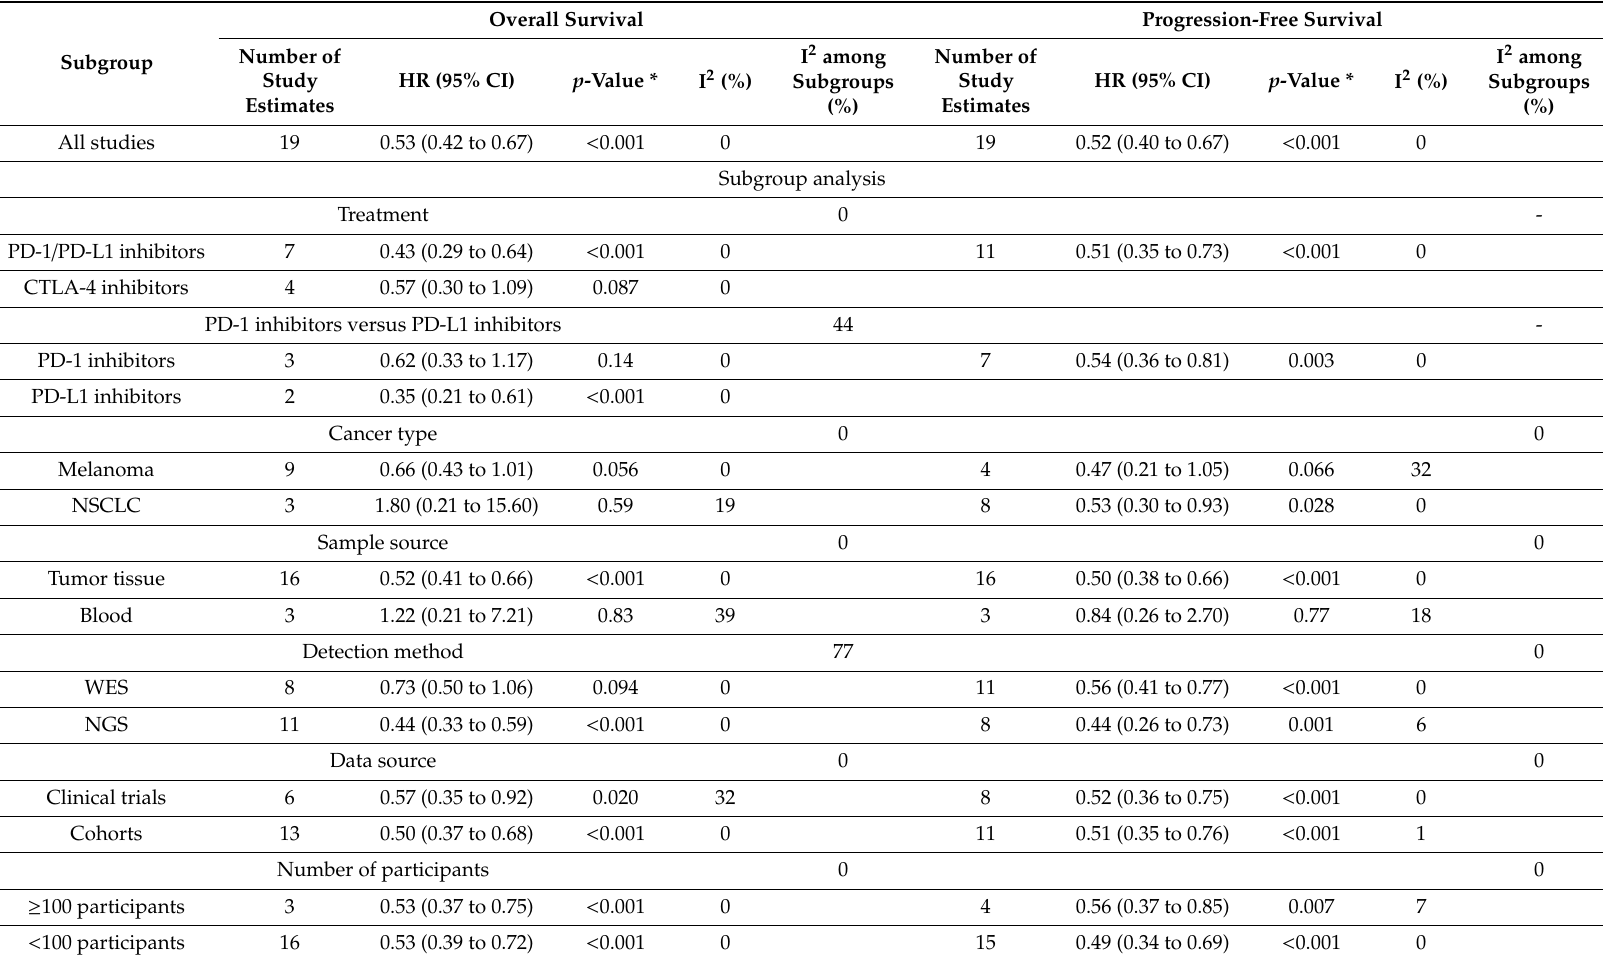
Table 3. Results of the subgroup analysis of the high TMB group versus low TMB